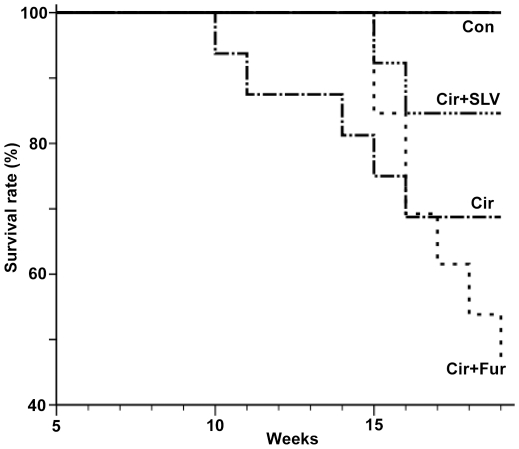
Kaplan-Meier mortality chart of rats with liver cirrhosis (Cir; mortality 5/14), cirrhotic rats with furosemide treatment (Cir+Fur; 7/13), cirrhotic rats with SLV329 treatment (Cir+SLV; 2/12) and all control groups without liver cirrhosis (Con; 0/24).p<0.05 for Cir+Fur vs. Cir+SLV (log-rank test).